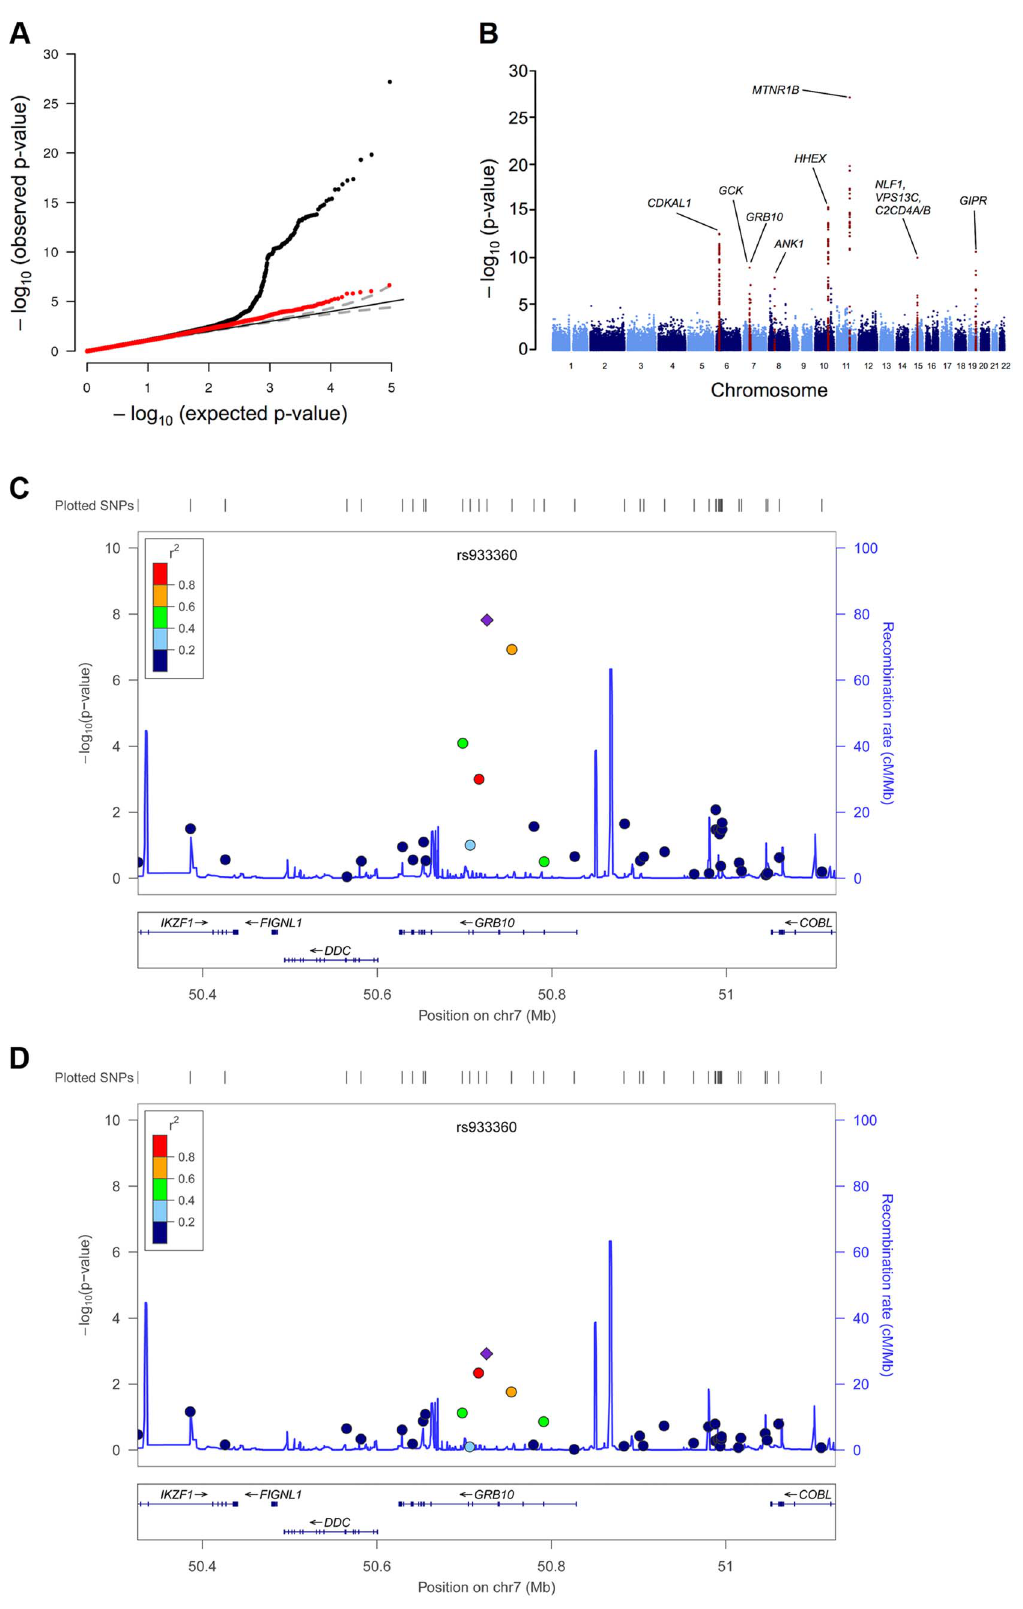
Figure 1. GWAS plots identifying GRB10 rs933360. Genome-wide quantile-quantile (Q-Q) (A) and Manhattan (B) plots for CIR in the meta- analysis. Regional plots of identified GRB10 genome-wide significant association for CIR in men (C) and women (D). Directly genotyped and/or imputed SNPs of GRB10 are plotted with their meta-analysis p -values (as 2 log10 values) as a function of genomic position (NCBI Build 36). In each